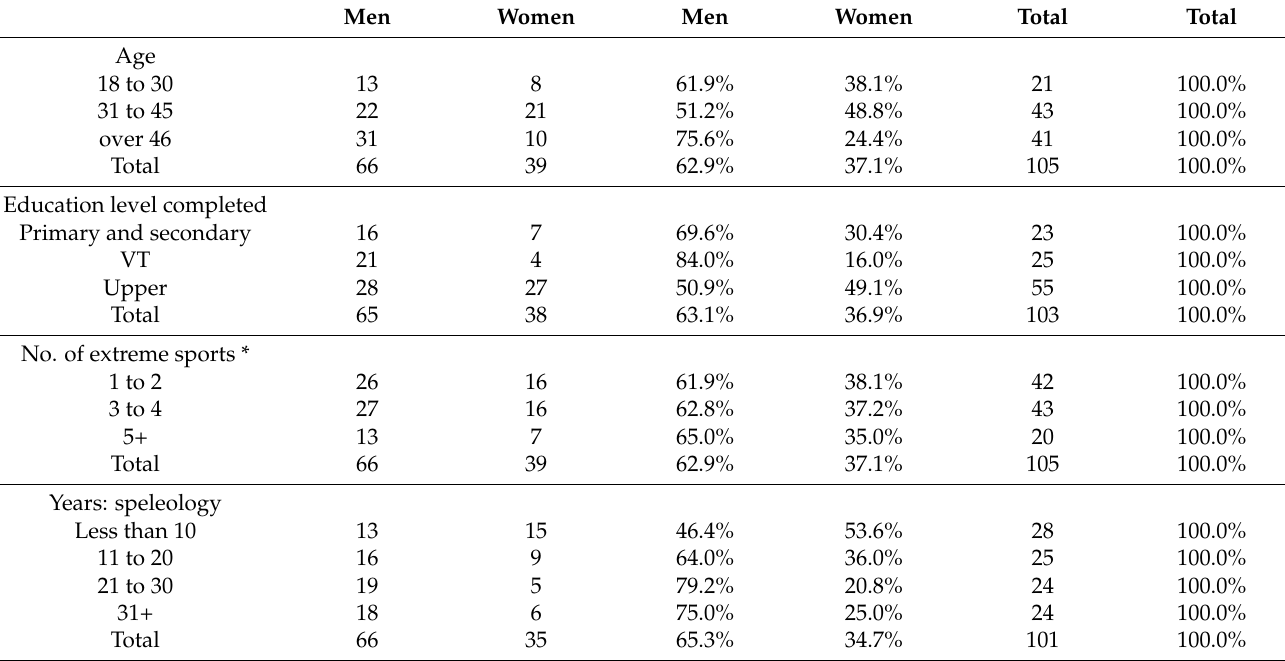
Table 1. Sociodemographic characteristics of the